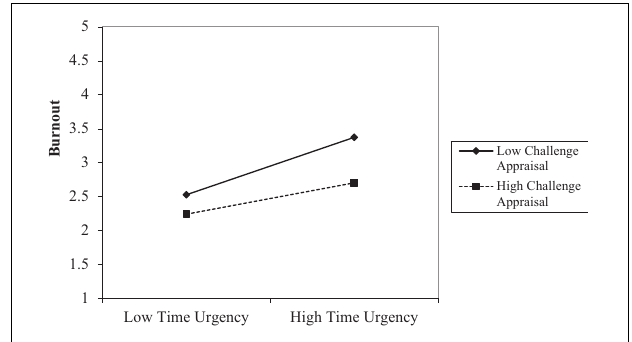
FIGURE 4 | The interaction between time urgency and challenge appraisal on burnout in Study